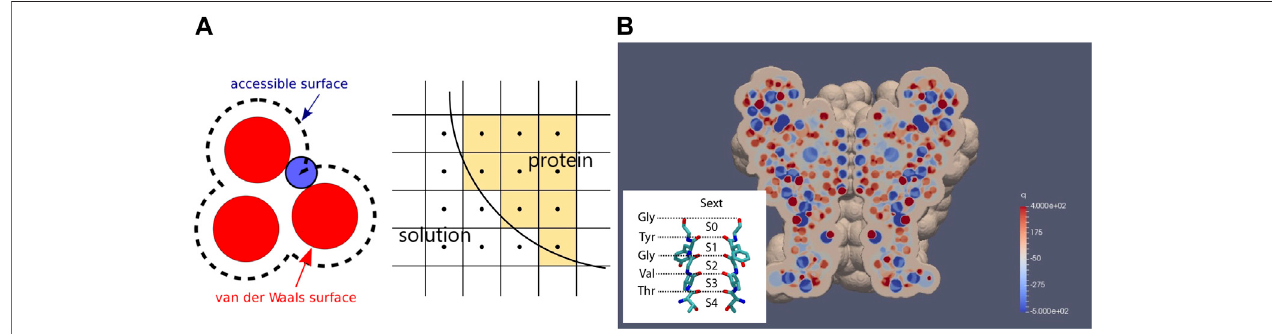
FIGURE 1 | Geometry of the continuum model. (A) generation of protein domain by rolling ball mechanism. A mesh with its center inside an accessible surface is classi fi ed as a protein mesh. Otherwise, the mesh is classi fi ed as a solution mesh. (B) cross-section of KcsA with permanent charge distribution. The structure of the narrowestpart ofthechannel,theSF,surroundedbycarbonyloxygensfromtheTVGYGmotifs, withitsbindingsites, isshownintheinset.Notethatunlikeconventional notation, here, blue spots denote negative charges and red spots denote positive charges according to the color